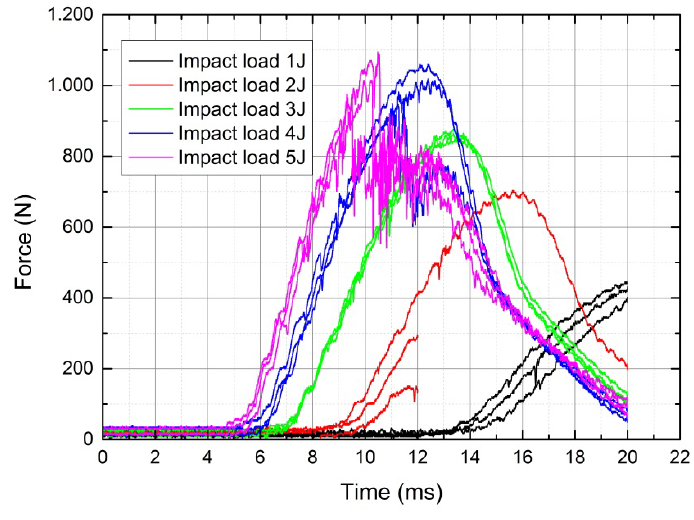
Figure 5. Impact result on the carbon test specimen for 1 J to 5 J.